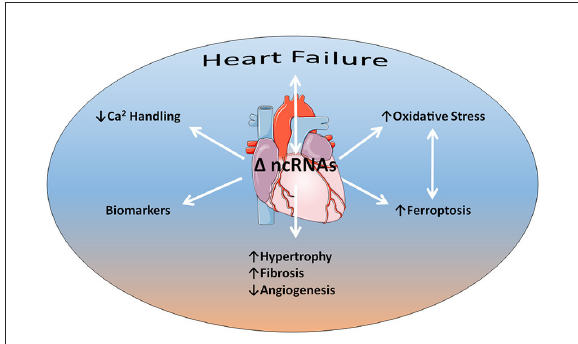
FIGURE1 Non-coding RNAs (ncRNAs) have an intimate relationship to heart failure as both agents of cause and consequence. Several aspects of this relationship discussed in the articles of the special research topic include impairments in calcium handling and increased oxidative stress that acts synergistically with iron-related programmed cell death (ferroptosis). Evidence indicates that alterations in ncRNA expression profiles underlie adverse cardiac remodeling, such as cardiac hypertrophy, fibrosis, and capillary rarefaction or angiogenic impairment. In addition, ncRNAs may serve as biomarkers for heart failure progression. Some content is adapted from Servier Medical Art (https://smart.servier.com/) under the terms of the Creative Commons Attributions 3.0 Unported